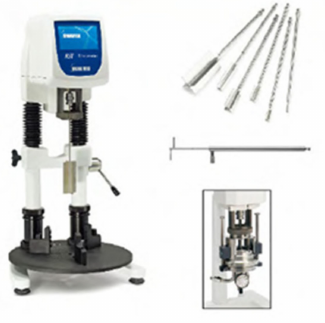
Figure 4. RST − SST